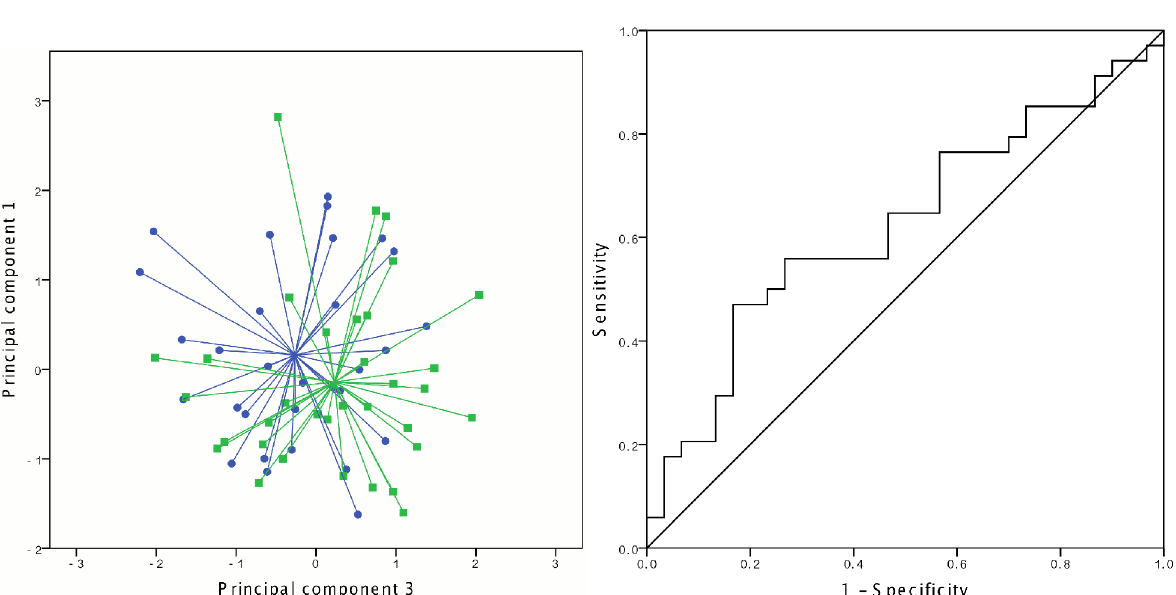
Fig. 2. Discrimination of chronically infected vs. non-chronically infected patients with cystic fibrosis. Left: two-dimensional principal component plot visualizing the chronically infected patients with green and non-chronically infected patients with blue. Right: ROC-curve for the discrimination (AUC 5 0.59).